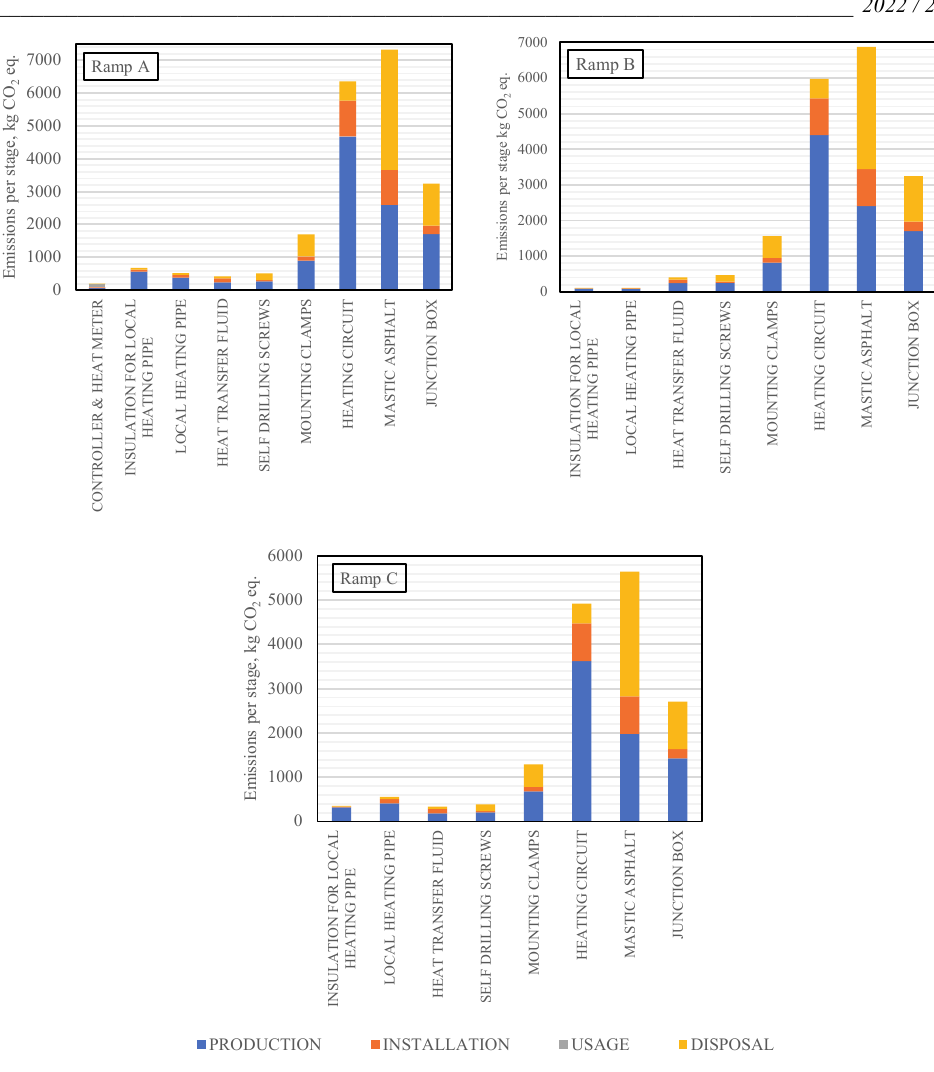
Fig. 4. Total GHG emissions of each contribution during life stages of the HRS of three ramps A–C in Ingolstadt. Over the service lifetime of 50 years, it is estimated that the Ingolstadt ramps with HRS will have a total global warming potential GWP T of 55.897·10 3 kg CO 2 eq., i.e. a specific environmental impact of 28.10 kg CO 2 eq./m 2 . and Transport and a corresponding life cycle investigation carried out in this study, a total GWP T of 68.104·10 3 kg CO 2 eq. by using salts as de-icers for the same area of 1989 m 2 over 50 years is calculated. Correspondingly, the emission factor for salts relative to unit area is 34.24 kg CO 2 eq./m 2 , which is 18 % higher as compared to the operational HRS in